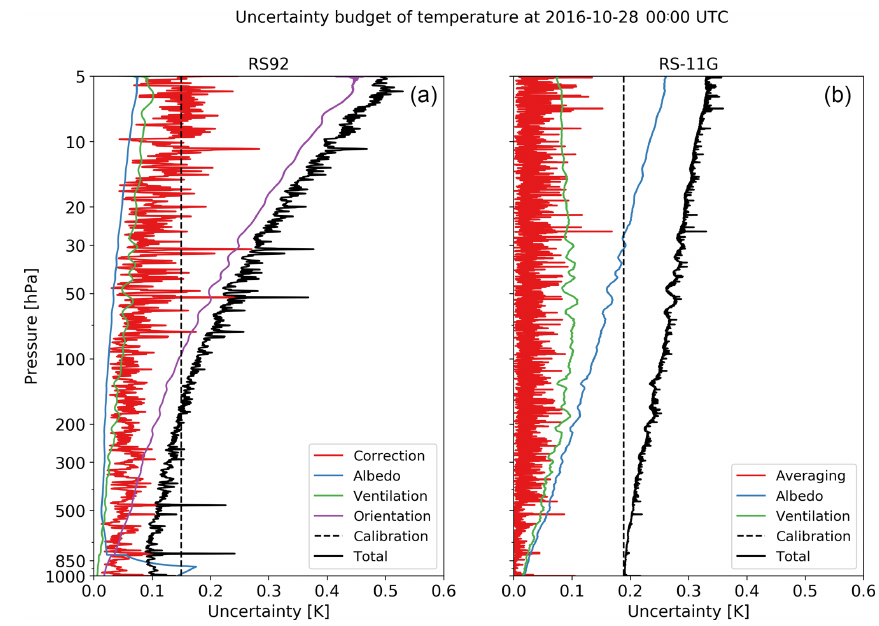
Figure 23. Uncertainty budget for temperature measurements at 00:00UTC (daytime) on 28 October 2016, for RS92 GDP (a) and RS-11G GDP (b) .